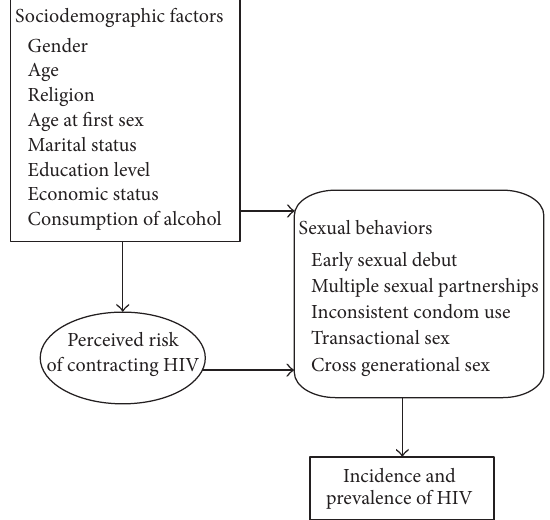
Figure 1: Conceptual